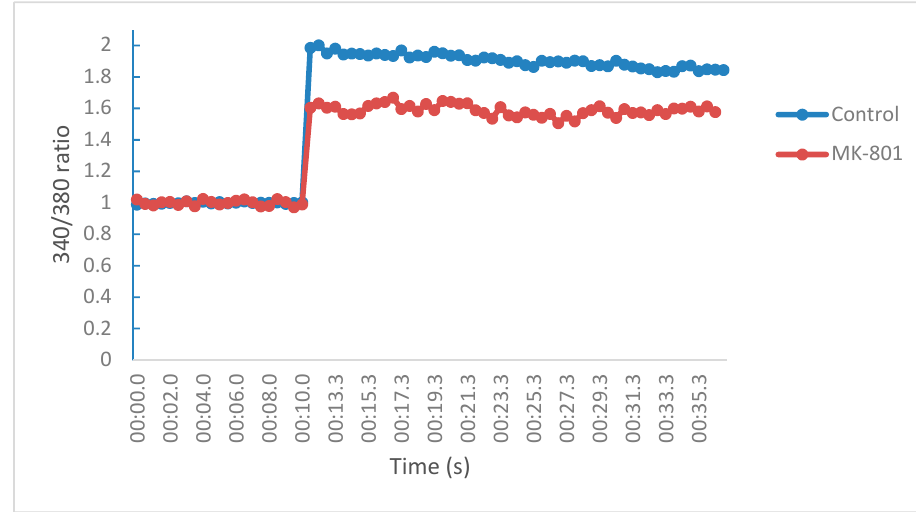
Figure 5. Fluorescence profile of SH-SY5Y neuroblastoma cells in a Fura-2 based assay in the presence or absence of positive control (MK-801) for NMDA receptor mediated Ca 2+ -studies.